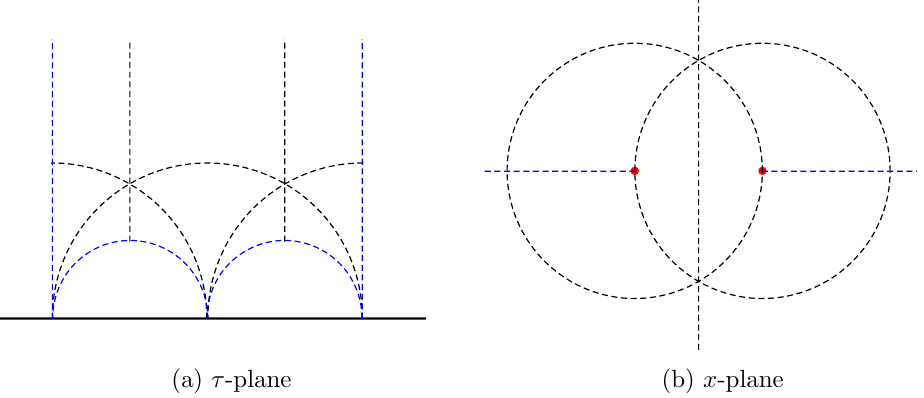
Figure 1. Fundamental domain for (cid:0)(2) in the upper half (cid:28) -plane, bounded by the blue dashed curves. T 2 identi(cid:12)es the left and right vertical lines, and ST 2 S identi(cid:12)es the semicircles. The three cusps at (cid:28) = i 1 , 0 and (cid:6) 1 correspond to x = 0 ; 1 ; 1 . The black dashed lines show how this domain breaks up further into six fundamental domains for the modular group (cid:0) (four of which are split in two across the blue lines). These six domains correspond to the images in the cross-ratio x -plane under the anharmonic group, shown in the right (cid:12)gure, where the marked points are at x = 0 ;